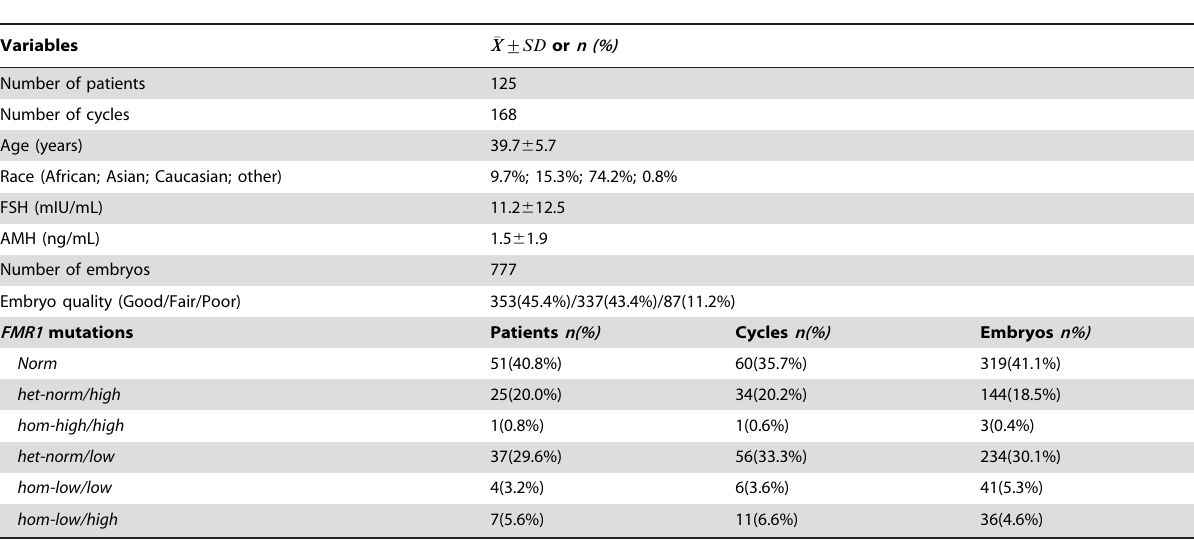
Table 1. Characteristics of infertile patients in section